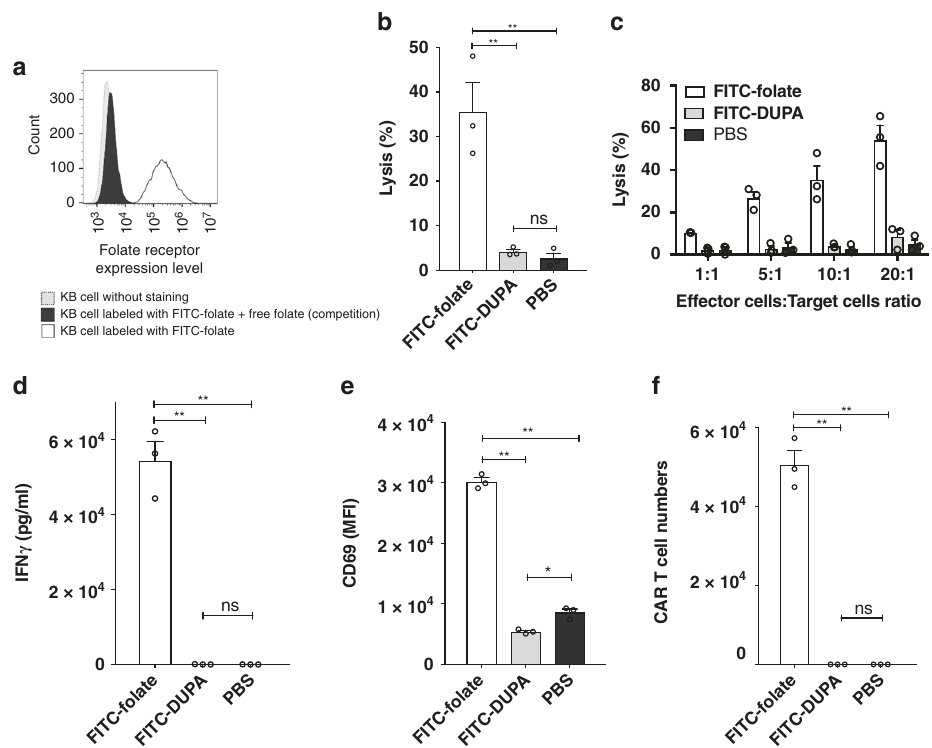
Fig. 2 Demonstration that FITC-folate bispeci fi c adapter mediates anti- fl uorescein CAR T cell engagement with folate receptor-expressing cancer cells (KB cells). a Demonstration that FR is expressed on KB cells. Grey histogram: KB cells without staining; Black histogram: KB cells labeled with 100 nM FITC- folate in the presence of excess (10 μ M) free folate as competitor; Open histogram: KB cells labeled with 100 nM FITC-folate. b Cytotoxicity of CAR T cells towards KB cells upon addition of correct FITC-folate (100 nM) but not mismatched FITC-DUPA (100 nM) or no (PBS) adapter. c Impact of effector:target cell ratio on CAR T cell lysis of KB cells in presence of FITC-folate, FITC-DUPA, or no adapter. d IFN γ production is induced by addition of FITC-folate (100 nM) but not FITC-DUPA (100 nM) (after 24 h co-culture). e Expression of activation marker (CD69) on anti- fl uorescein CAR T cells occurs only upon addition of correct adaptor (after 24 h co-culture). f Proliferation of anti- fl uorescein CAR T cells is induced by FITC-folate but not FITC-DUPA (after 5 days co-culture). For panels b , d – f , the ratio of anti- fl uorescein CAR T cells to KB cells was 10 to 1. Bar graphs represent mean ± s.d. n = 3. One-way ANOVA with post-hoc Tukey tests were performed for all comparisons (* denotes a p- value < 0.05, ** < 0.01, ns = not signi fi